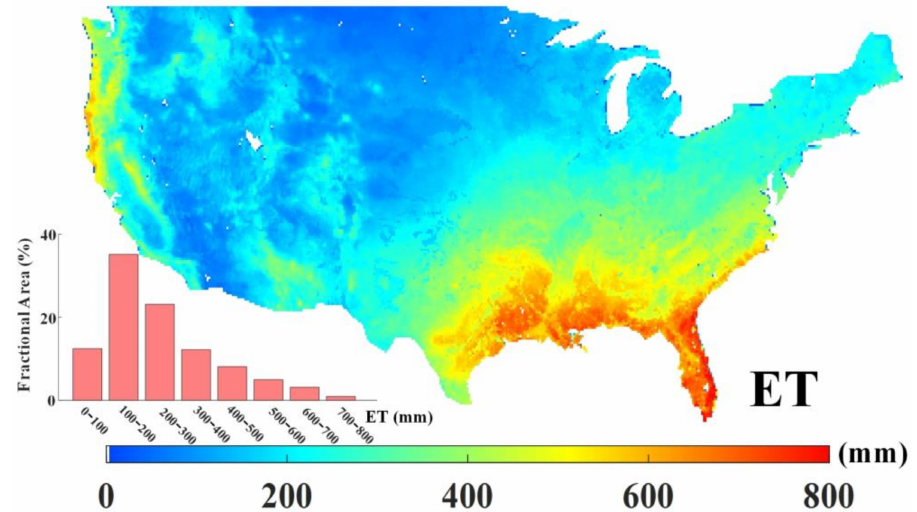
Figure 2. Spatial distribution of 30-year averaged evapotranspiration (ET) from the Bayesian-based three-cornered hat (BTCH) method.